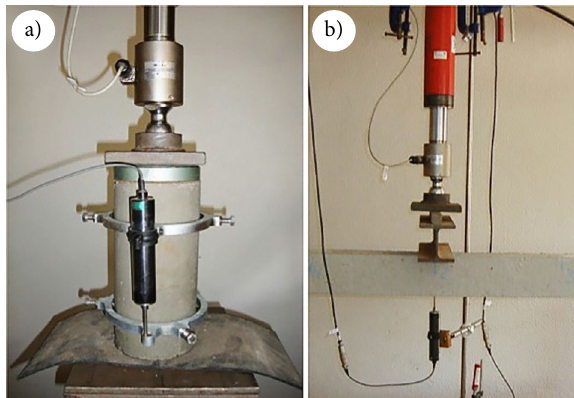
Fig. 3. Adopted procedure for the Young’s modulus determination: a) cylindrical specimen test;